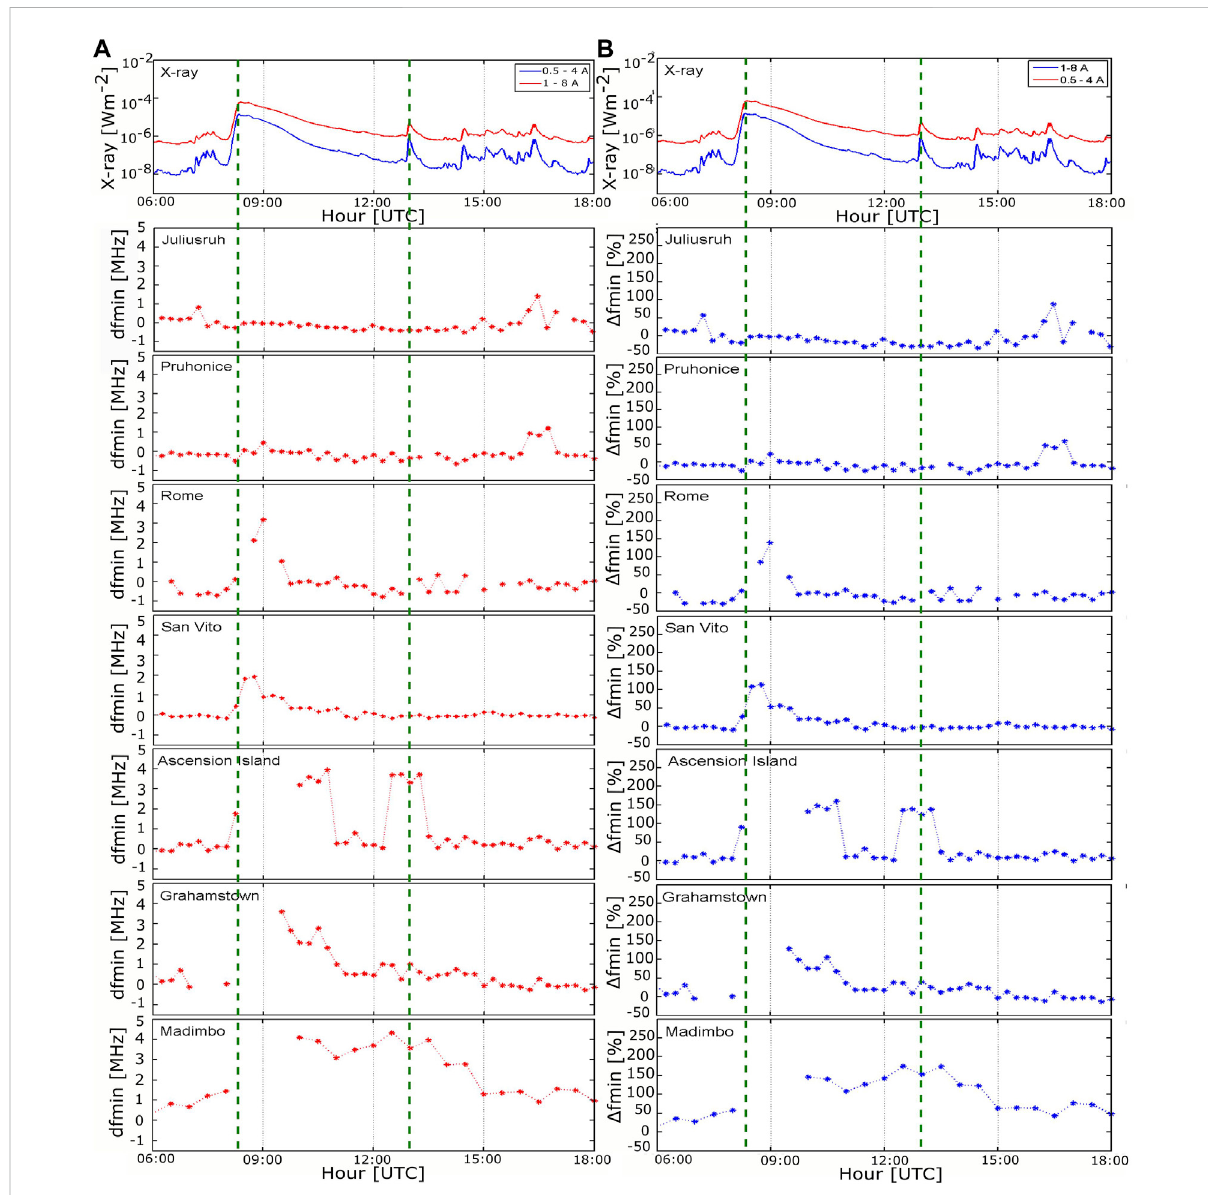
FIGURE 6 ThevariationofX-ray fl ux(upperplots)andthedfmin (A) and Δ fminparameters (B) detectedatdifferentstations(fromhighertolowerlatitudes) between 06:00 and 18:00 on 06 December. The green dashed lines indicate the time of the investigated fl